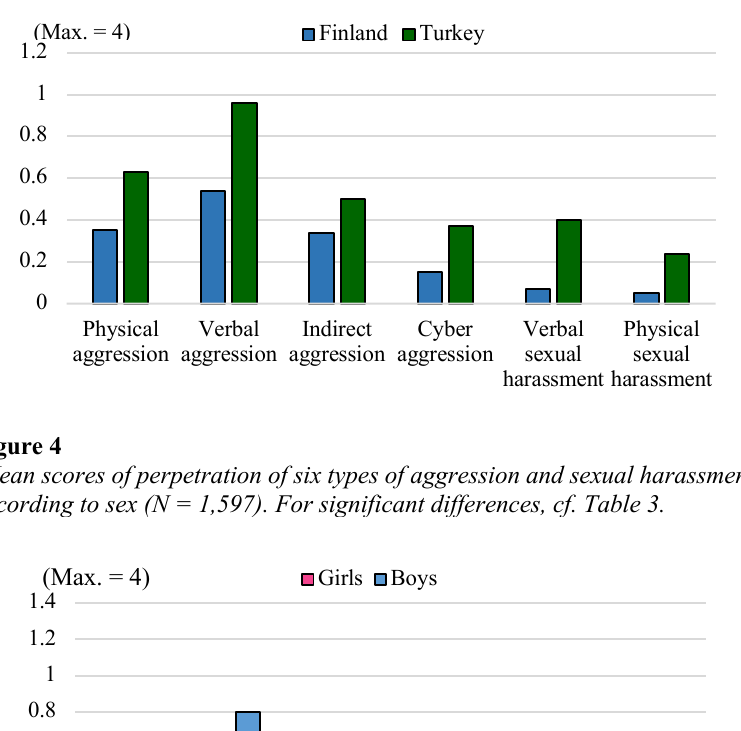
Mean scores for perpetration of six types of aggression and sexual harassment, according to country of residence (N = 1,597). For significant differences, cf.